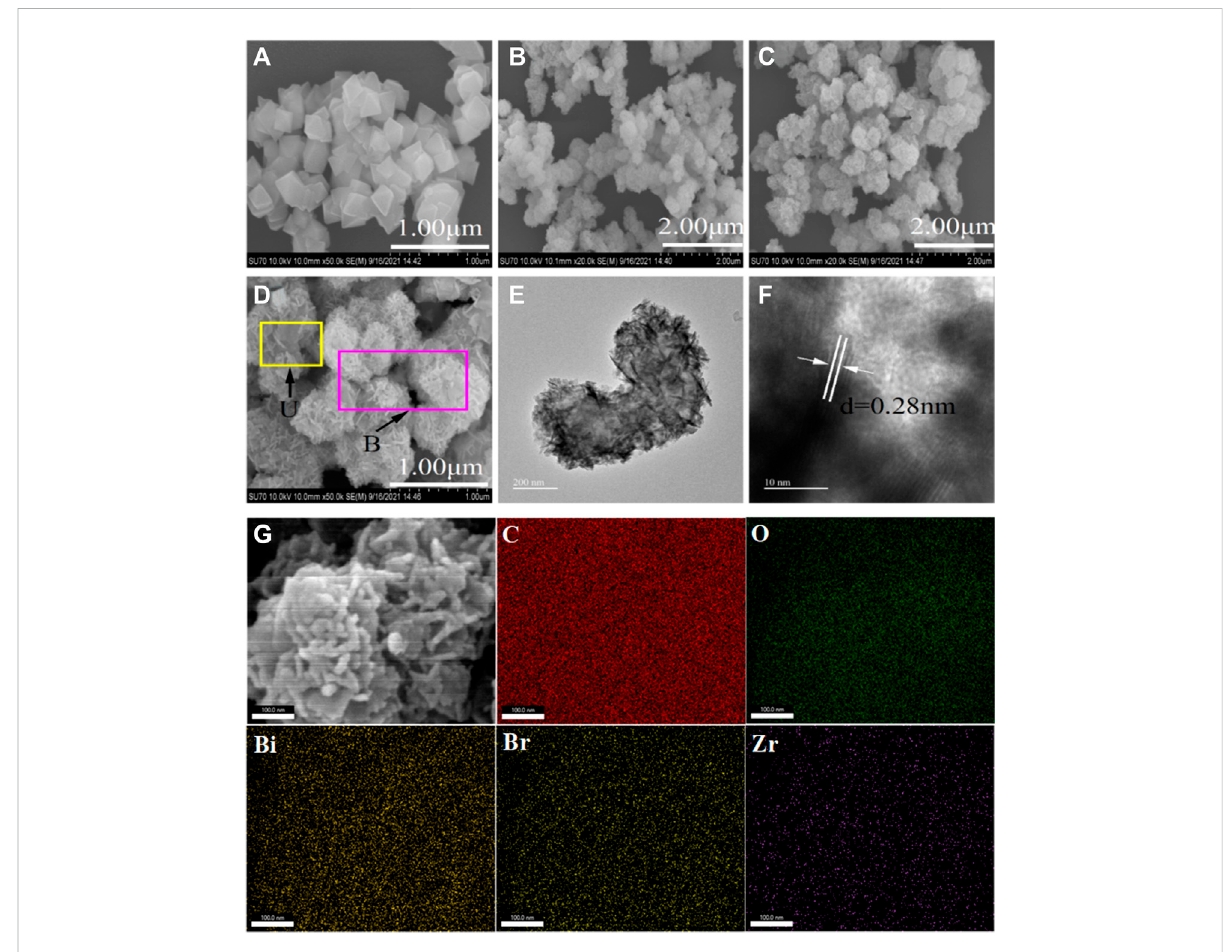
FIGURE 2 The morphologies of photocatalysts: SEM images of (A) U, (B) B and (C,D) UB-30%; TEM (E) and HRTEM (F) of UB-30%; EDS mapping of UB- 30% (G)